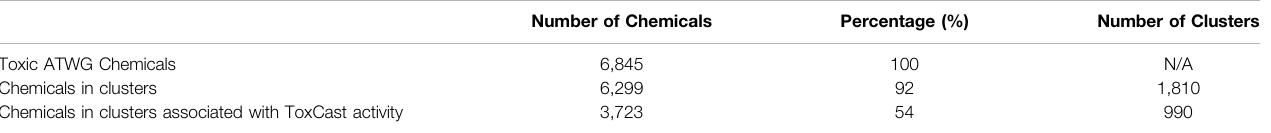
TABLE 4| Coverage ofthe acute oral toxicity chemical spaceEvaluation ofthe percentage of toxic chemicals from the ATWG list covered bystructural clustersand ToxCast